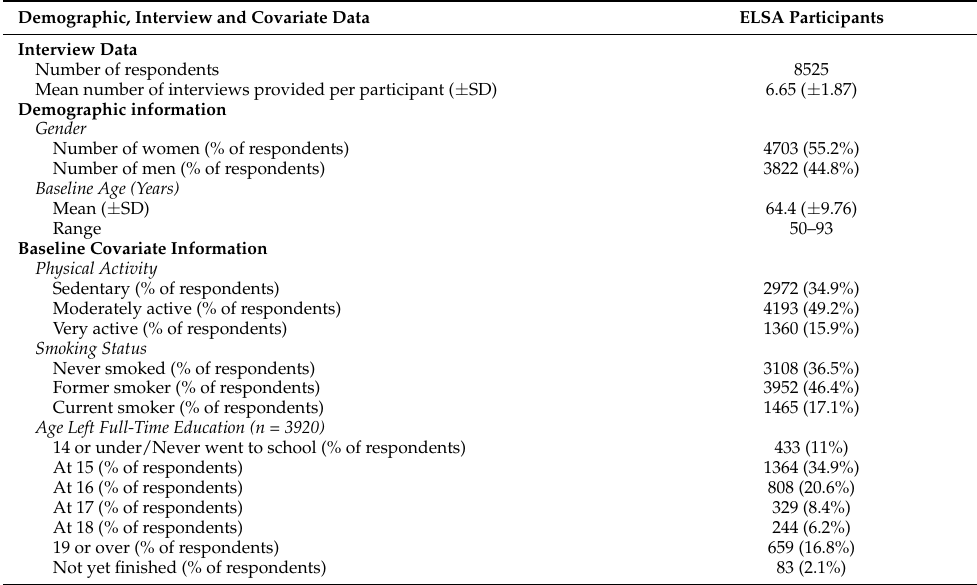
Table 1. Baseline (Wave 2) descriptive statistics for demographic, interview and covariate data for ELSA respondents included in analysis of dementia incidence.